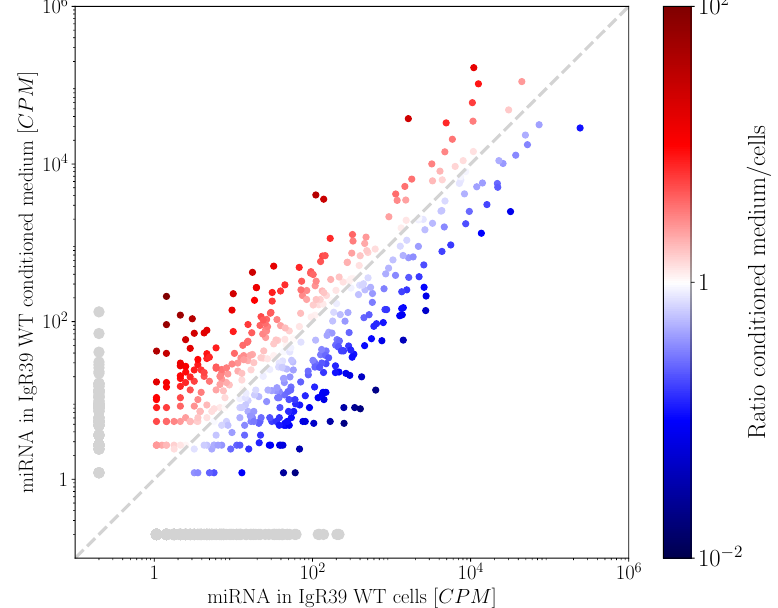
Figure A3. Expression of miRNA in conditioned medium (CM) obtained from WT IgR39 after 16 h in comparison to the level of expression of miRNA in the cells. The graph shows the average expression over two replica as counts per million [CPM]. Colors correspond to fold change expression in conditioned medium compared to the level found inside the cells. Gray dots identify miRNA detected only in one of the two conditions. The gray dashed line is a visual